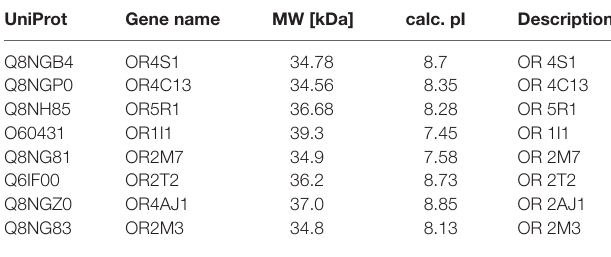
Table 1 | Identified olfactory receptors (ORs) in seminal plasma by proteomics.